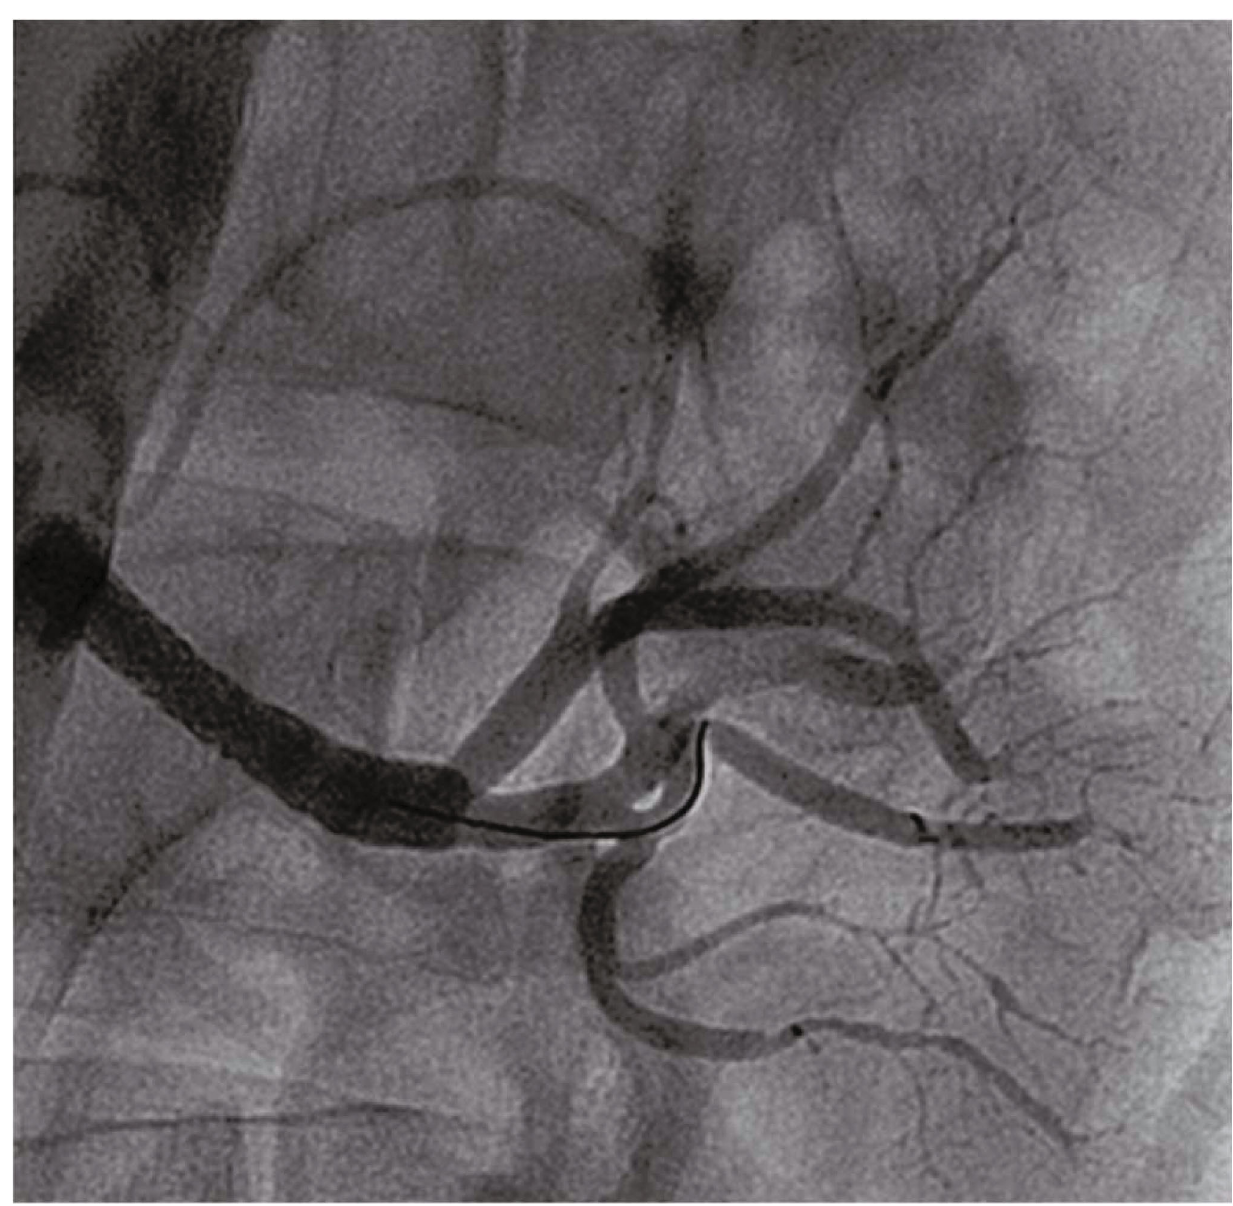
Figure 7: The poststent angiography reveals much better renal perfusion with patent renal lobular and arcuate arteries, but distal vessels still look in spasm and with some distal